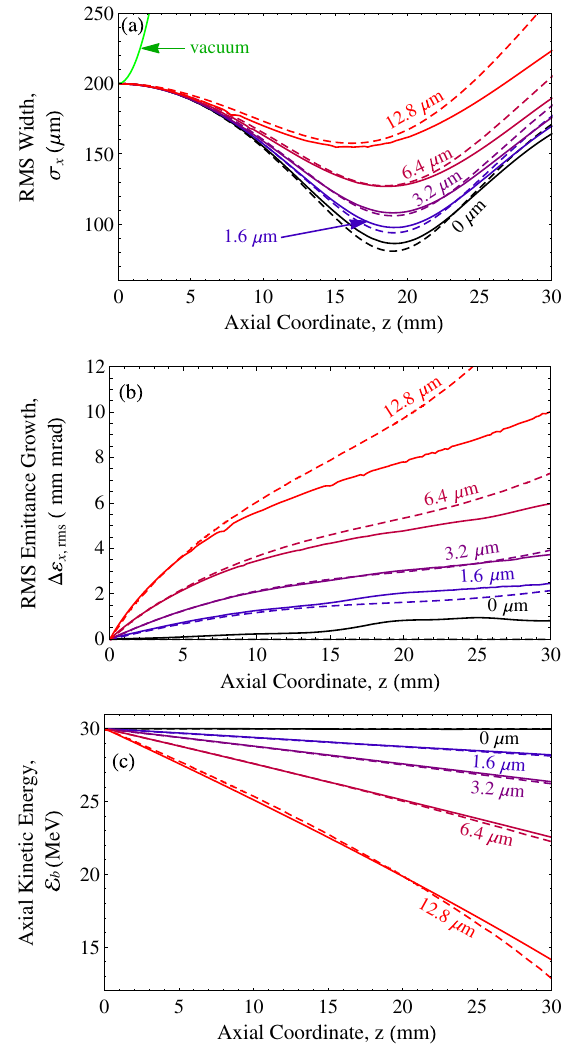
FIG. 7. The evolution of rms beam width σ (a), rms transverse x emittance growth Δ ε (b), and axial kinetic energy E (c) as a x; rms b function of z for foil spacing L ¼ 100 μ m and foil thickness Δ ¼ 0 , 1.6, 3.2, 6.4, 12 . 8 μ m as labeled. Quantities at the focal f ) are summarized in Table. I. spot ( z position of the smallest σ x Dashed lines represent the envelope model solutions. Solid lines represent WARP simulations.